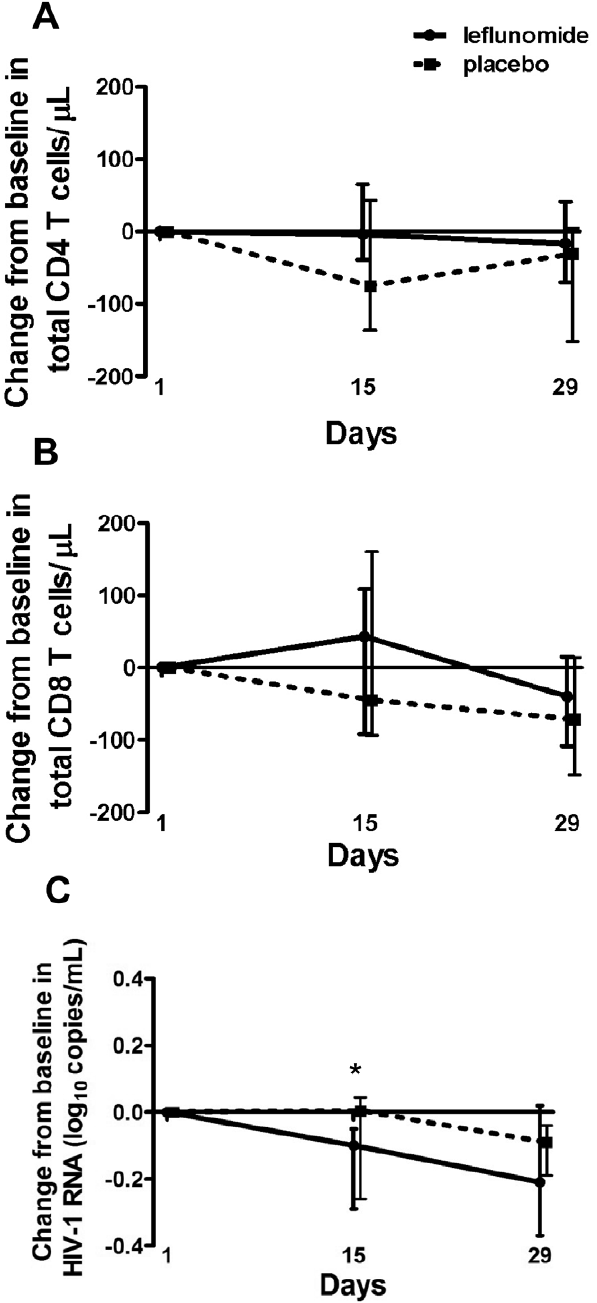
Figure 2. Changes in T cell counts and HIV viral load. A) Changes from baseline in CD4 T cell counts, and B) CD8 T cell counts throughout the study duration; median values and interquartile ranges; C) Change from baseline in HIV plasma viral load; median values and interquartile ranges. There was a significant decrease in HIV-1 RNA at Day 15 in the leflunomide group (*p-value , 0.05).